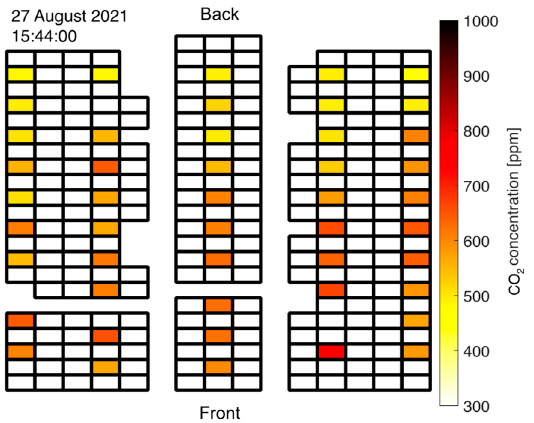
Figure 7. Calibrated barometric pressure readings in at-grade exam room. Sensor unit IDs are color-coded.